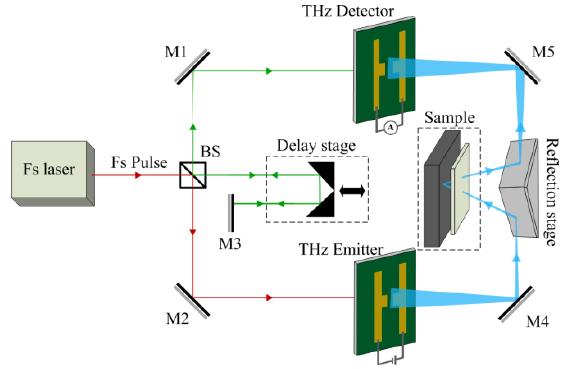
Figure 3. Schematic of the experimental setup. BS: splitter; M: mirror.